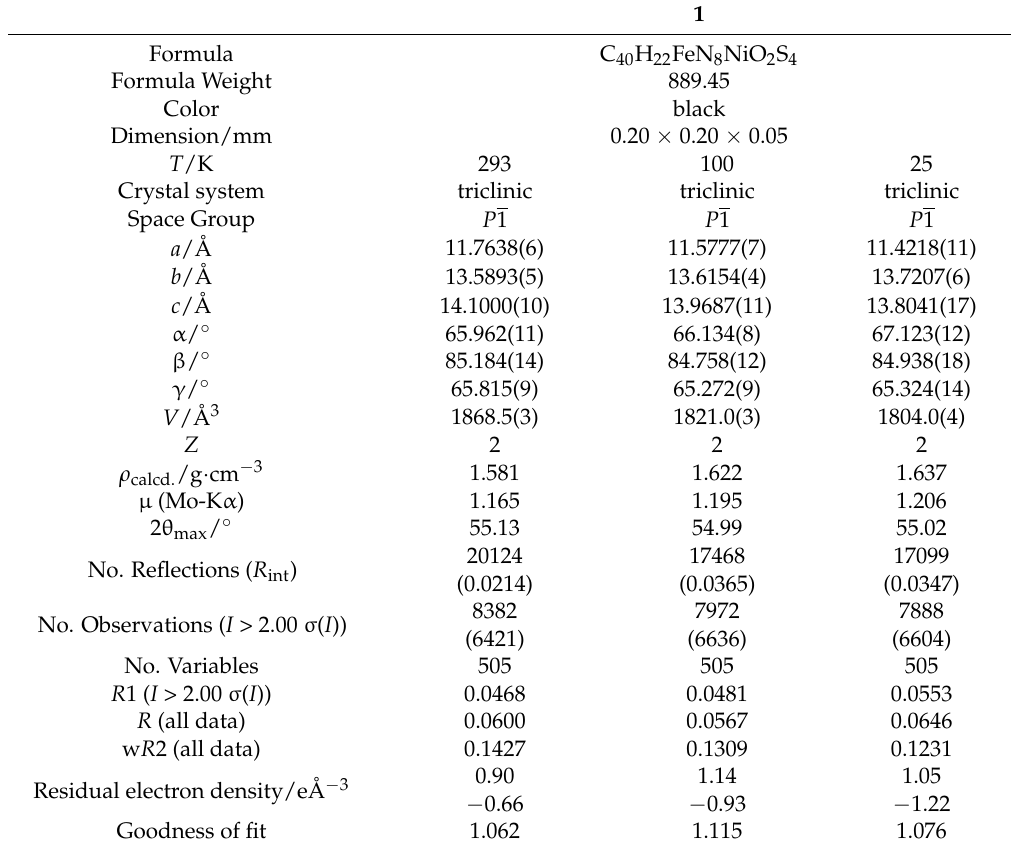
Table 1. Crystallographic data for 1